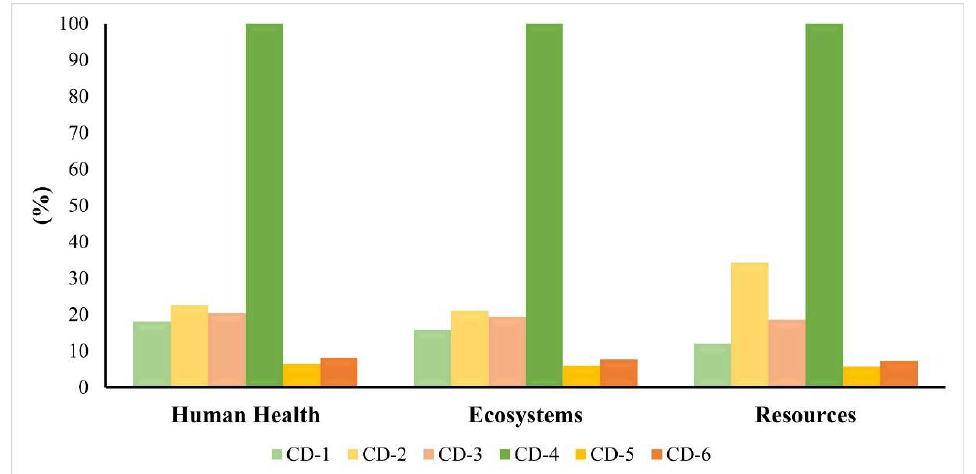
Figure 3. Relative environmental impacts of syntheses under study for landfill disposal scenario, applying ReCiPe method. Green scale refers to hydrothermal treatments; Yellow scale refers to microwave-assisted treatments; Orange scale refers to calcination treatments.